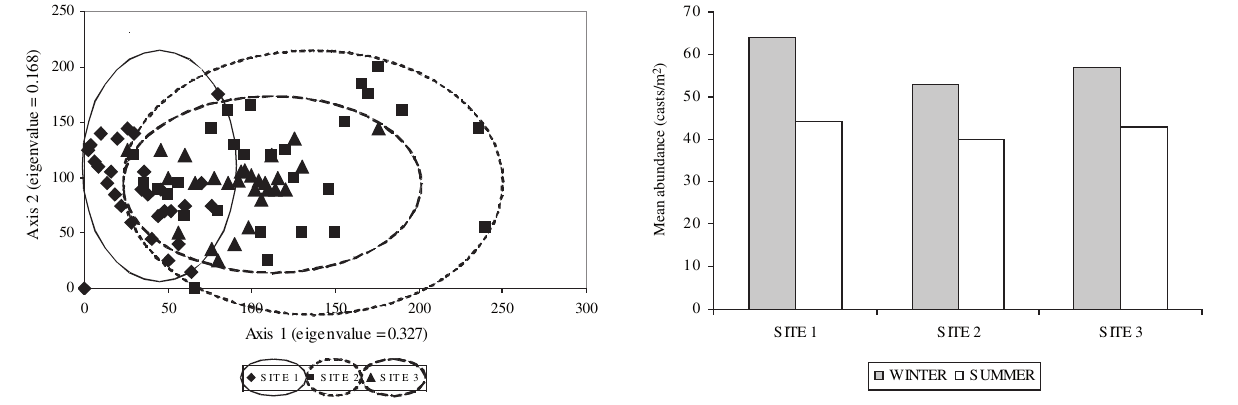
Fig . 2. – Comparison of diversity indices at three sampled sites during 1994-1996 for benthic macrofauna at Culbin Sands lagoon, NE